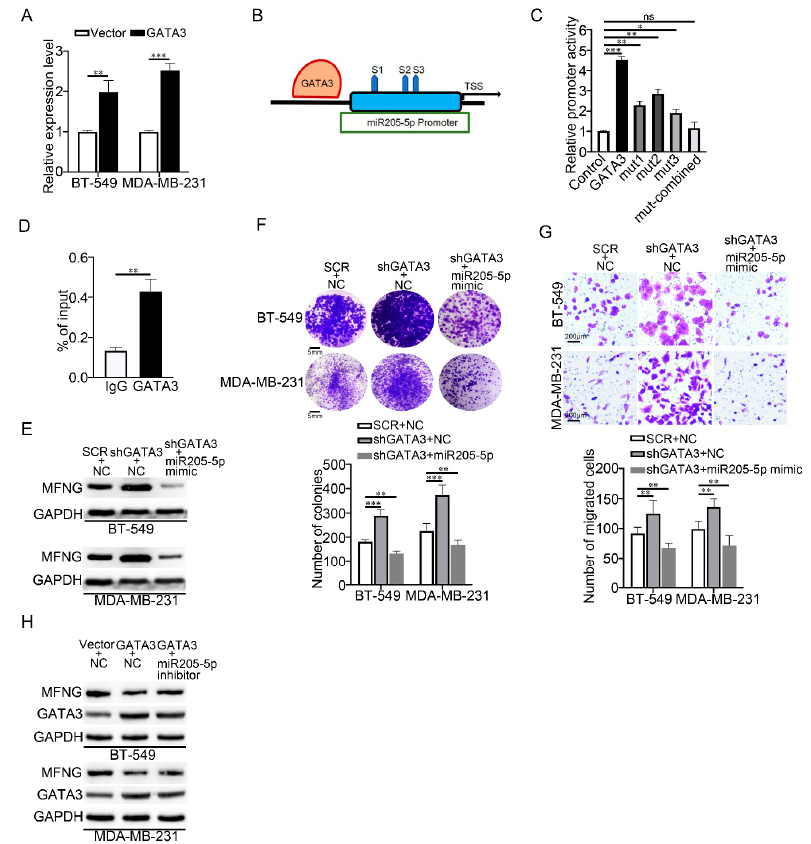
Figure 6. GATA3 activated miR205-5p transcription and formed a feed-forward loop with miR205-5p and MFNG in TNBC. ( A ) RT-qPCR analysis for miR205-5p in TNBC cells overexpressing GATA3. ( B ) The predicted binding sites for GATA3 on the miR205-5p promoter using bioinformatics. ( C ) The luciferase and ( D ) ChIP assays were performed to examine the regulation of GATA3 on miR205-5p transcription in MDA-MB-231 cells, IgG served as the negative control. ( E ) Protein expression level of MFNG in control, shGATA3/NC, and shGATA3/miR205-5p cells, GAPDH was loaded as the internal control. ( F , G ) Colony formation and transwell assays were used to assess the effect of miR205-5p mimic on cell growth and metastasis of GATA3-knockdown TNBC cells. ( H ) Protein expression level of MFNG in the control, GATA3/NC, and GATA3/miR205-5p inhibitor cells, GAPDH was loaded as the internal control. Data were analyzed using a Student’s t -test. All * p < 0.05, ** p < 0.01, *** p < 0.001, ns: not